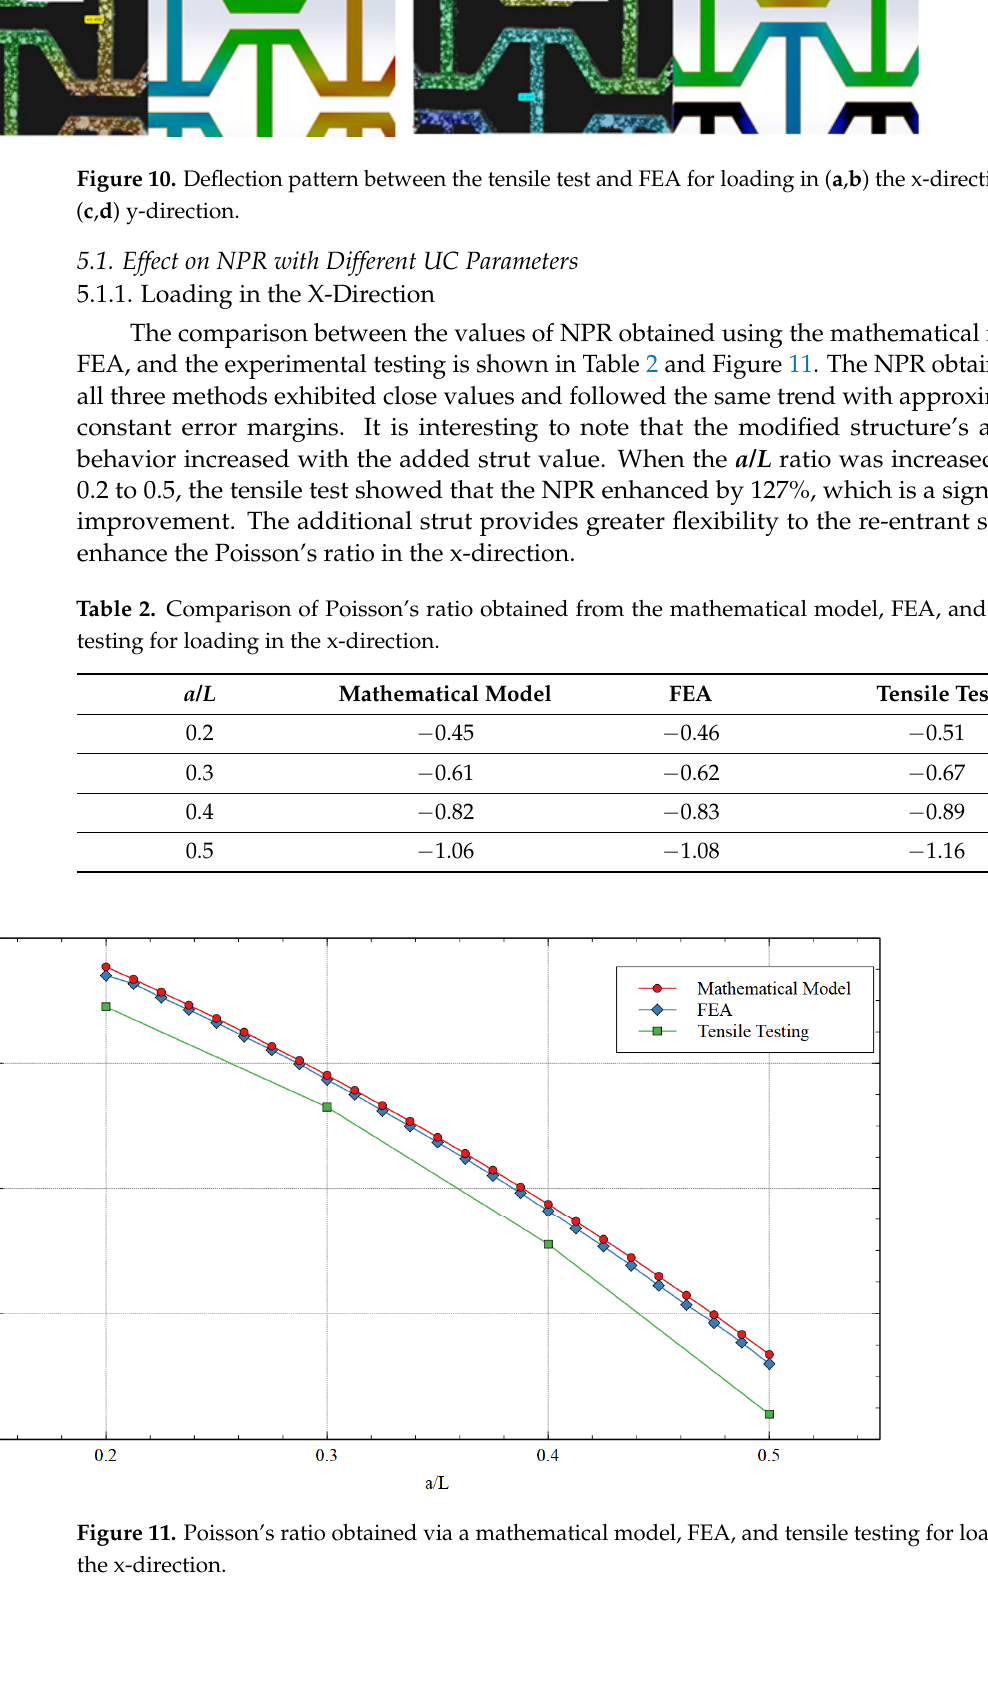
in the x-direction. the